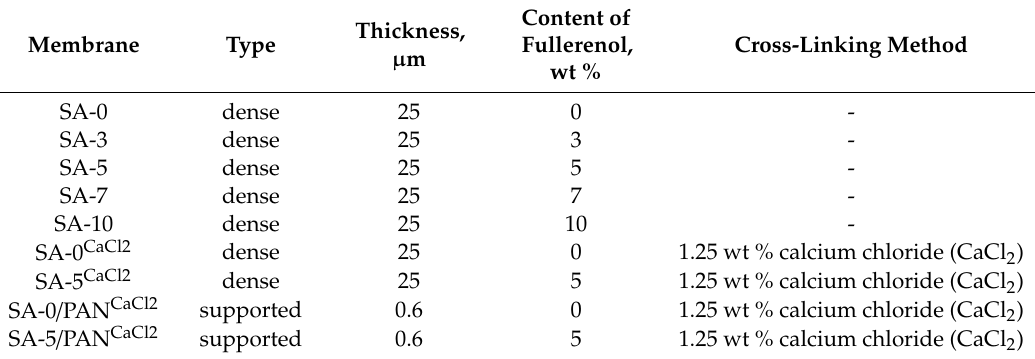
Table 1. Developed membranes based on sodium alginate (SA).